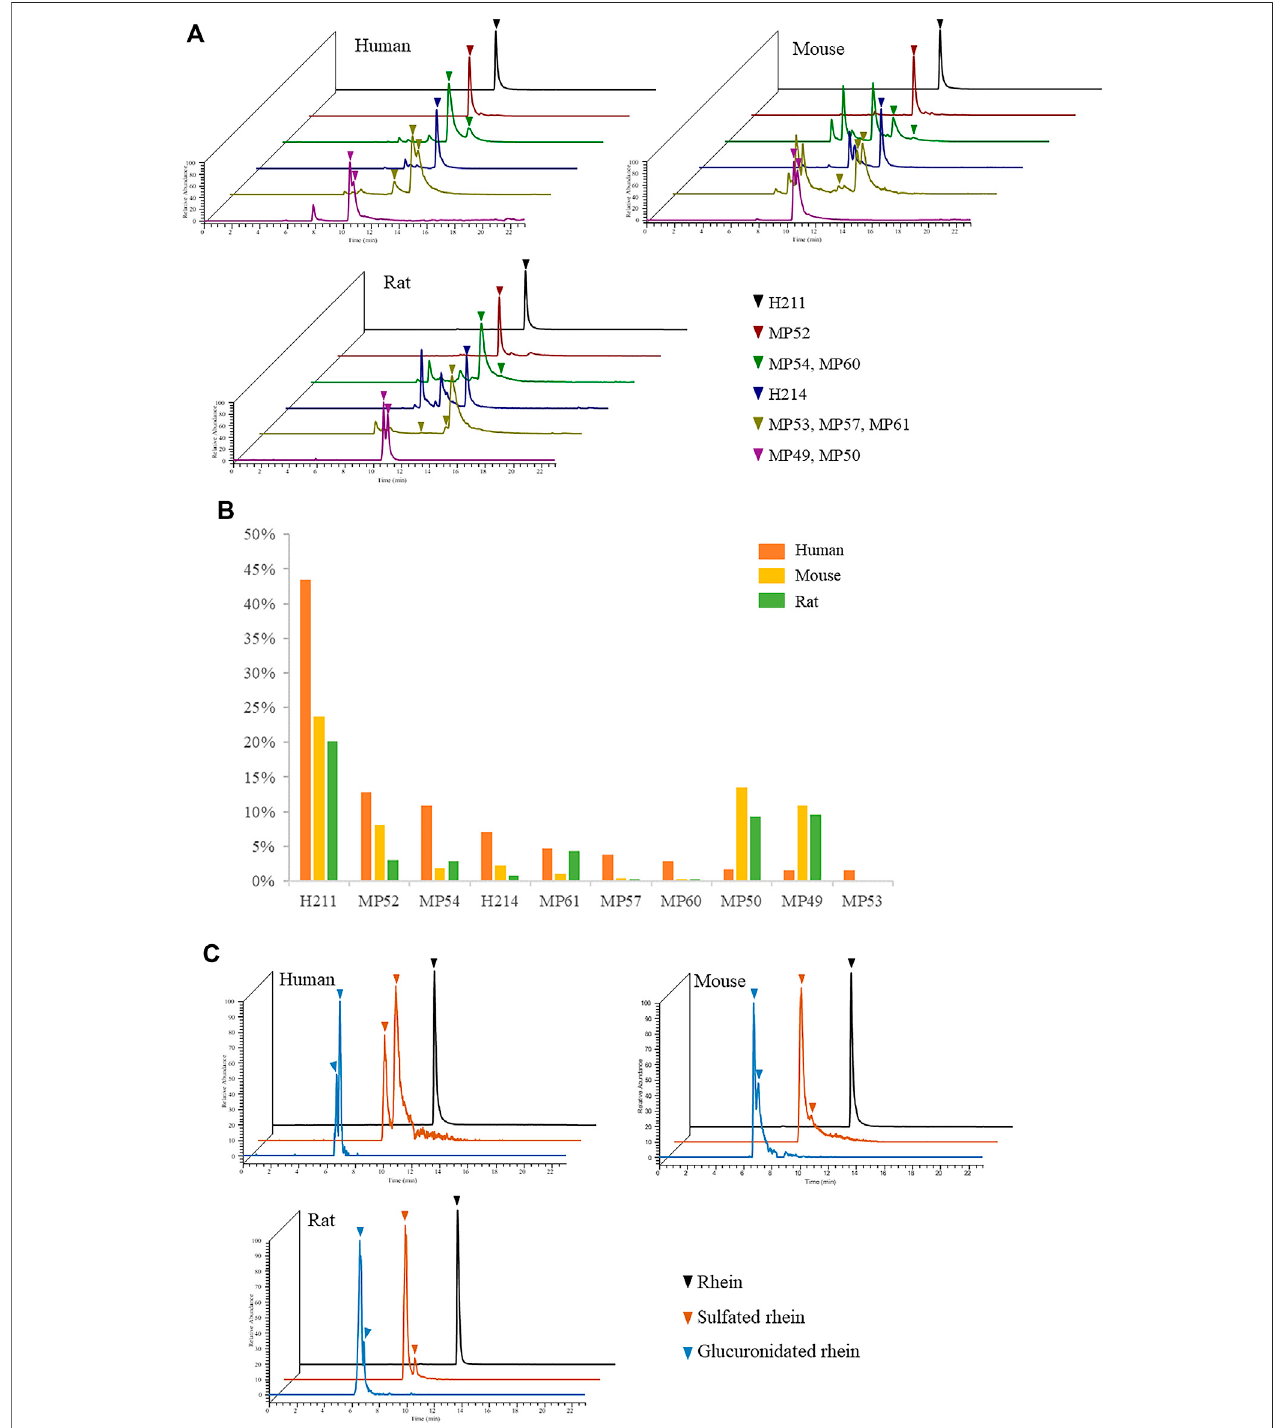
FIGURE5| Metabolismofrhubarbinhumans,rats,andmice. (A) Exposureofthetop10compoundsinhumanexposureindifferentspecies; (B) Proportionofthe top 10 compounds in human exposure in different species; (C) Metabolism of rhein in different species.